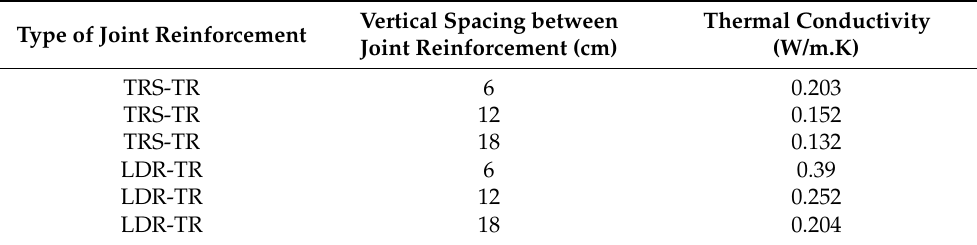
Table 3. Thermal conductivity of 3DPC wall reinforced with LDR-TR and TRS-TR steel wire joints at various vertical spacings between joint